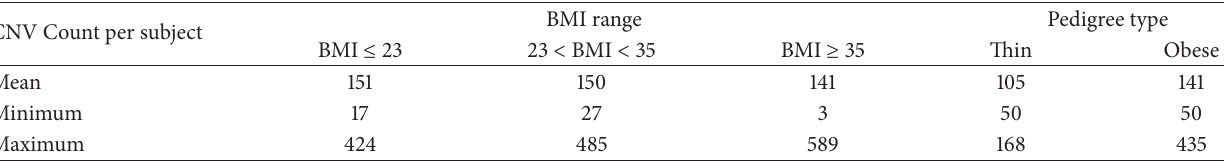
Table 2: Mean, minimum, and maximum number of CNVs (LRR > 0.3 or LRR < − 0.3) per subject by BMI range and by pedigree